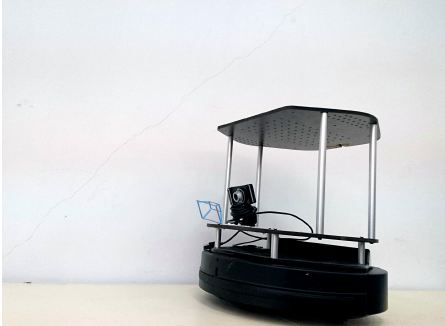
Figure 2. Illustration of the set-up of the camera; it is fixed on the mobile robot platform in the heading